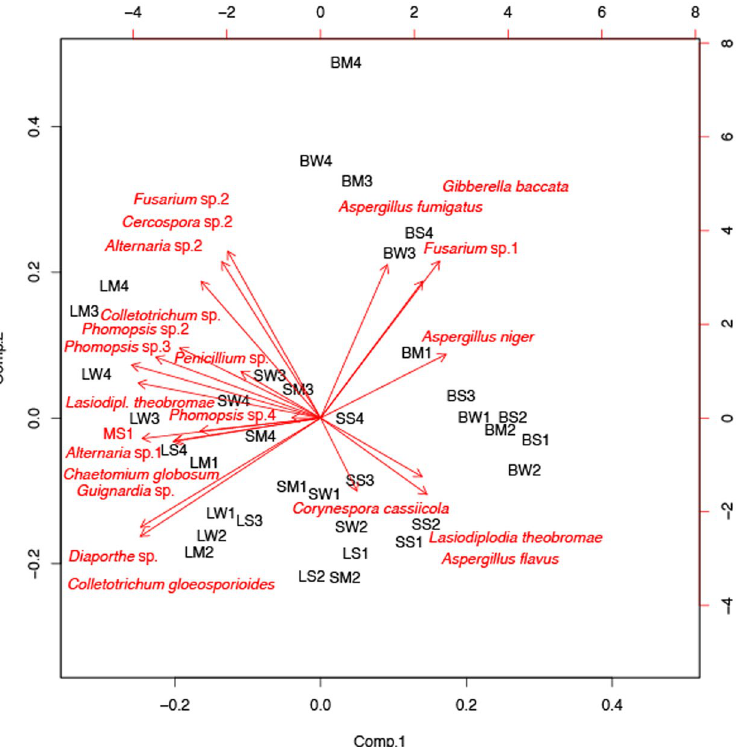
Figure 3. Biplot (Principal components analysis) depicting the relationship between fungal endophyte taxa (arrows) and sampling units (tissue type, season and location). The longer the arrow the more influence has the fungus connected with it, and the further removed a sampling unit gets positioned from the centre the stronger its influence. The closer a sampling unit and a fungal taxon the stronger is their relationship. The first letter of the three-letter acronyms denotes the tissue type (B, barks; L, leaf; S, stem), the second the season (W, winter; S, summer; M, monsoon), and the third the location.